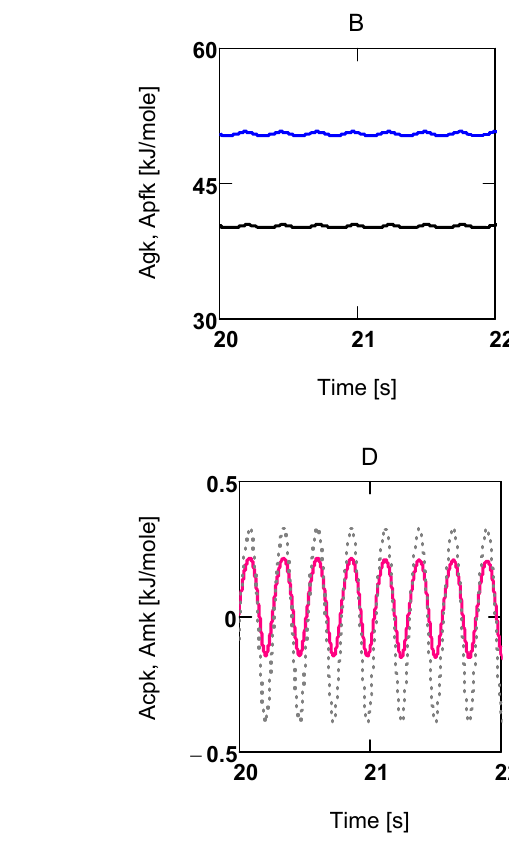
; (cyan) J ; (blue) J . At steady state J Ald Ti Ga